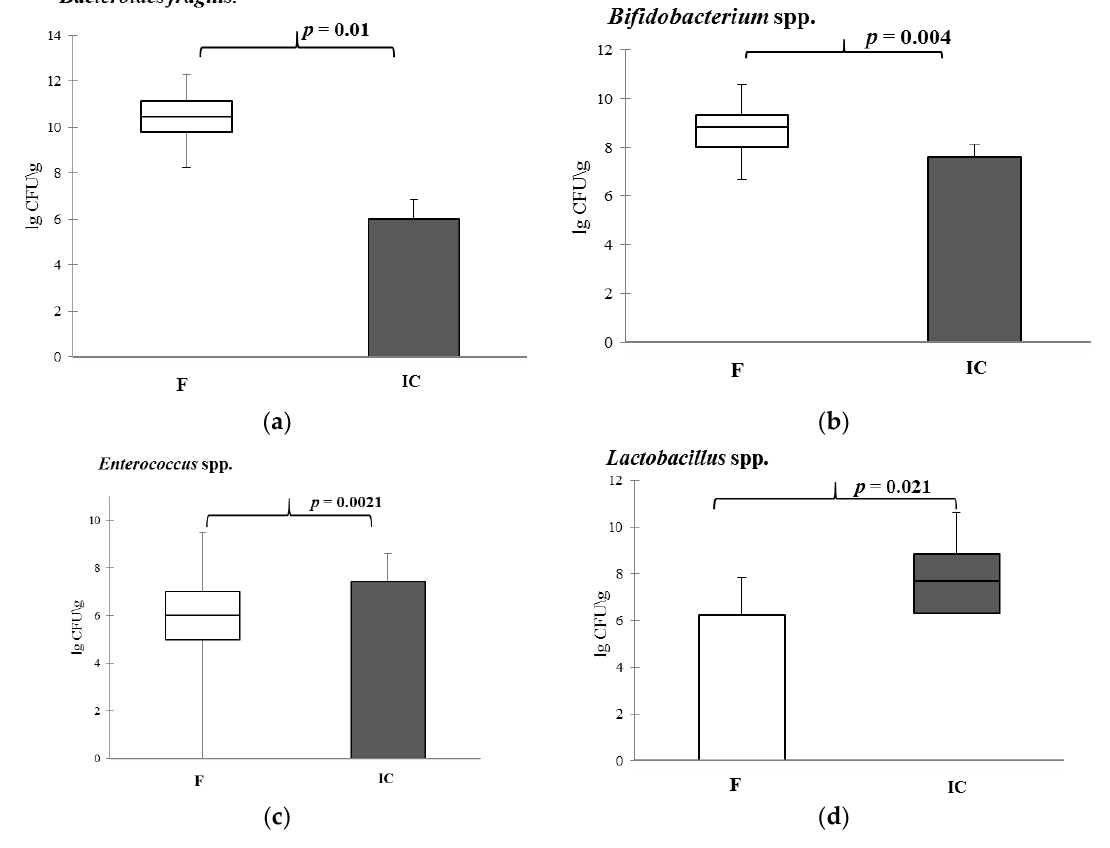
Figure 2. Quantity content of Bifidobacterium ( a ), Bacteroides fragilis ( b ), Enterococcus ( c ) and Lactobacillus ( d ) genera in the fecal samples and indigenous consortiums. Notes: F—fecal samples; IC—indigenous consortium. Results are presented as median (25%; 75%). Table 1. Frequency of different taxa identification in the composition of fecal samples and the indigenous consortium by qPCR